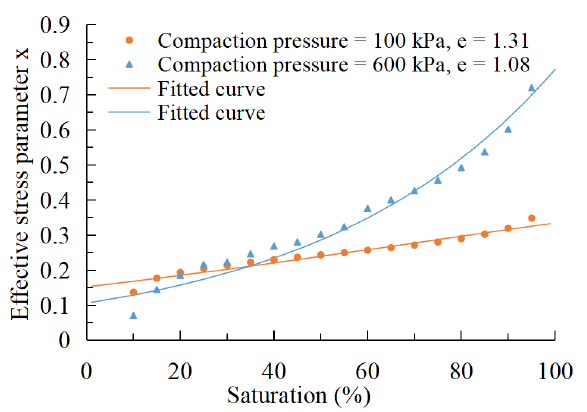
Figure 19. Effective stress parameter χ of the calculated points and fitted curve at different com- paction pressures.